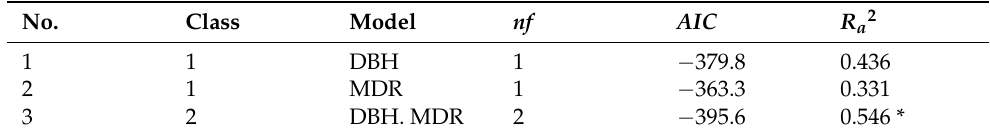
Table 9. Model performances of candidate models for predicting wood density based on different models (control variant).